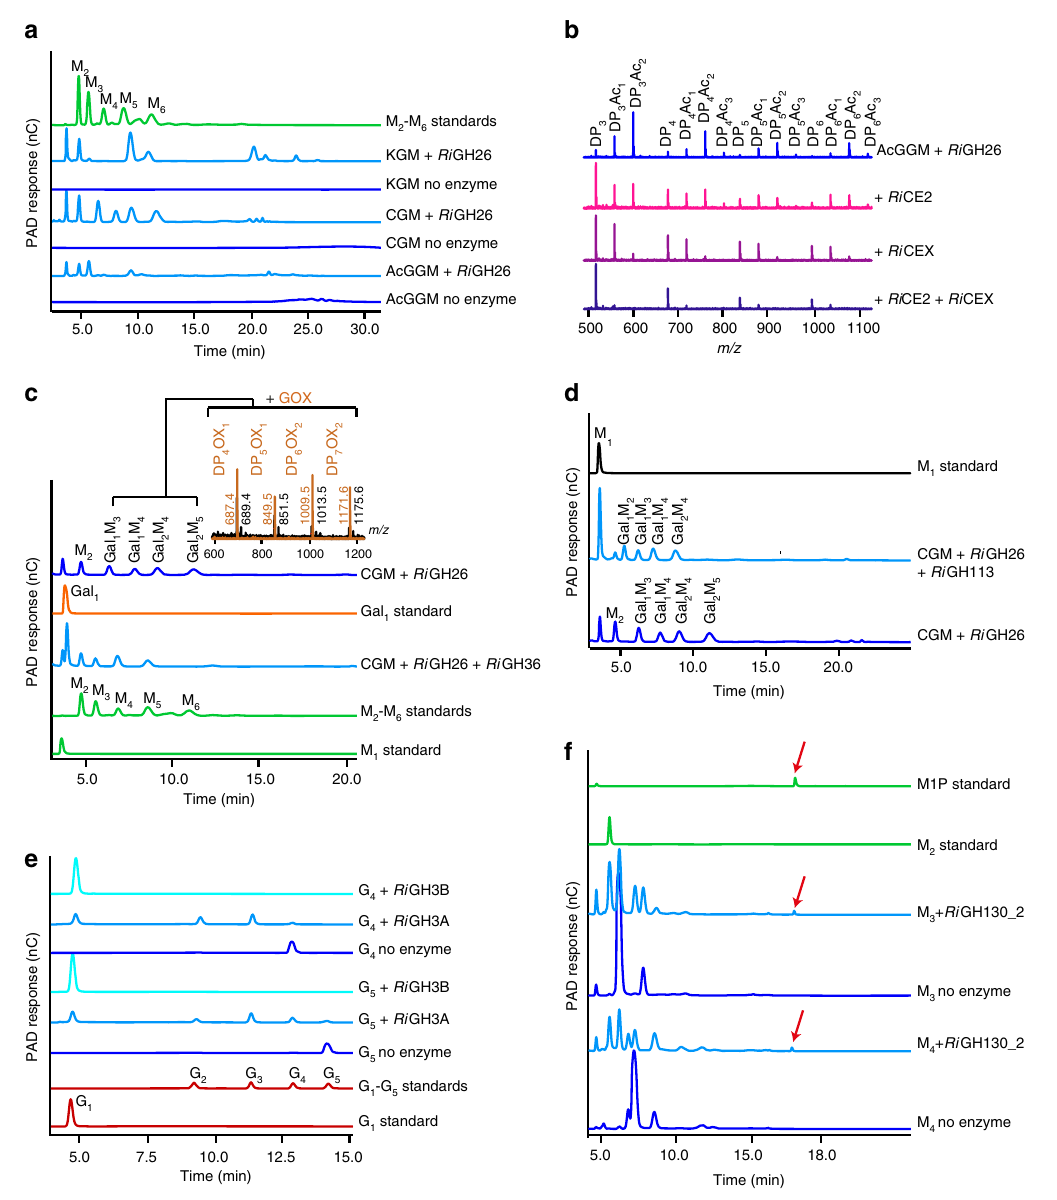
Fig. 4 Cleavage of the β -mannans backbone, removal of the side chains and further depolymerization of the resulting linear manno-oligosaccharides. a HPAEC chromatograms showing the oligosaccharide products after overnight digestion of KGM, CGM and AcGGM with Ri GH26. Samples were analyzed with the following manno-oligosaccharides as external standards: M 2 , mannobiose; M 3 , mannotriose; M 4 , mannotetraose; M 5 , mannopentaose; M 6 , mannohexaose. b MALDI-TOF analysis of Ri GH26-digested AcGGM incubated with either Ri CE2, Ri CEX or both enzymes. Peaks are labeled by DP and number of acetyl groups (Ac). c HPAEC chromatograms showing products generated from CGM pre-digested with Ri GH26 and subsequently treated with Ri GH36. Assignments for peaks not occurring in the standard samples are based on comparison with the product pro fi les obtained by MALDI-TOF MS of Ri GH26-digested CGM (black spectrum) treated with galactose oxidase (GOX; brown spectrum). GOX converts a galactose residue in the oligosaccharides into its corresponding aldehyde, giving a mass-to-charge ratio ( m/z ) of -2. All assigned masses are sodium adducts. Abbreviations: Ox, oxidation; Gal 1 , galactose; Gal 1 M 3 , galactosylmannotriose; Gal 1 M 4 , galactosylmannotetraose; Gal 2 M 4 , digalactosylmannotetraose; Gal 2 M 5 , digalactosylmannopentaose. d Product pro fi les from Ri GH26-digested CGM degradation experiments with Ri GH113 analyzed by HPAEC-PAD. The release of mannose con fi rms the exo-activity of Ri GH113. e HPAEC-PAD traces showing activity of Ri GH3A or Ri GH3B towards G 5 and G 4 with the corresponding controls (no enzyme). Product pro fi les at various time points during the reaction are shown in Supplementary Fig. 6. Taken together, the data show that Ri GH3B is able to hydrolyze completely both tetramers and pentamers, producing glucose. Ri GH3A shows exo-activity towards both substrates that are converted slowly to glucose and a mixture of cello-oligosaccharides. Samples were analyzed with the following cello-oligosaccharides as external standards: glucose, G 1 ; cellobiose, G 2 ; cellotriose, G 3 ; cellotetraose, G 4 ; cellopentaose, G 5 . f Chromatograms showing products generated upon incubation of Ri GH130_2 with M 4 and M 3 . The M1P released (red arrow) was identi fi ed by co-migration with the appropriate standard. In all panels, the data displayed are representative of at least three biological triplicates